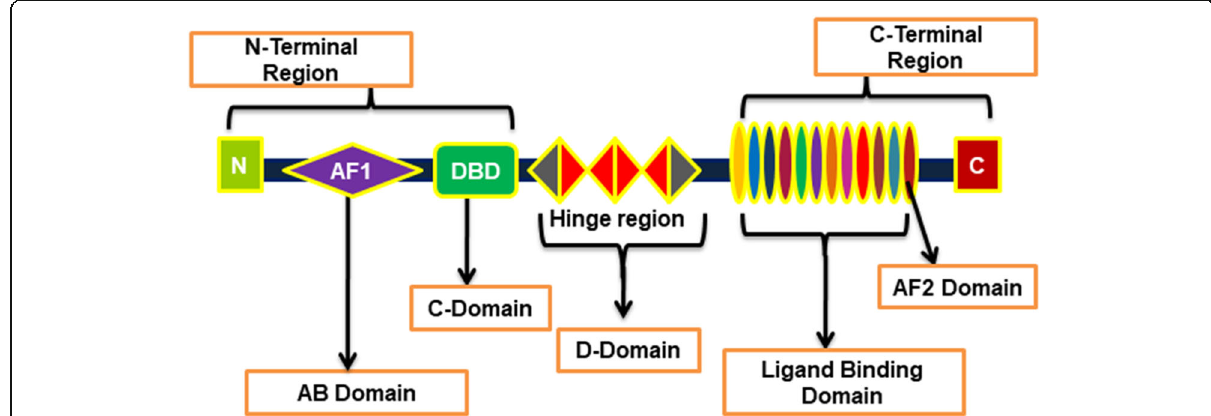
Fig. 1 Structure of Farnesoid X receptor (FXR). FXR consists of N-terminal region, hinge region and C-terminal region. The C-terminal region possesses an AF2 domain that plays an important role in activating